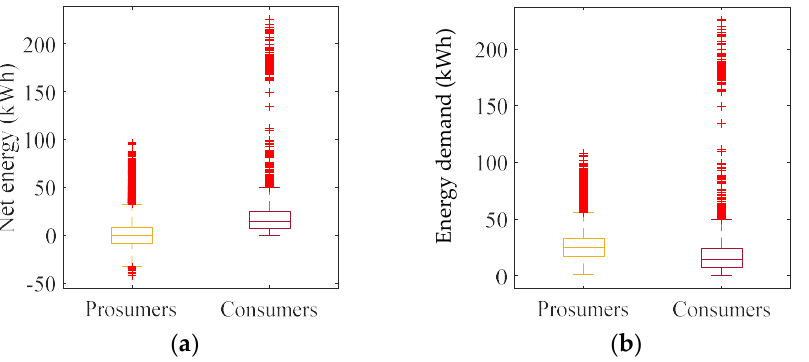
Figure 4. Distribution of ( a ) net energy demand and ( b ) energy demand between 9 am and 7 pm for the entire community.